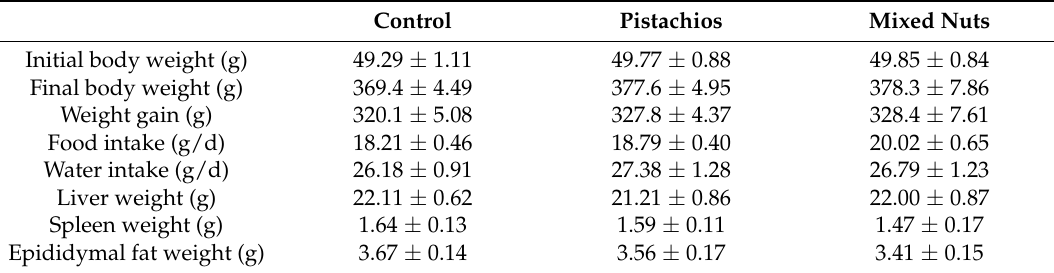
Table 1. Body and organ weights and food and water intake of